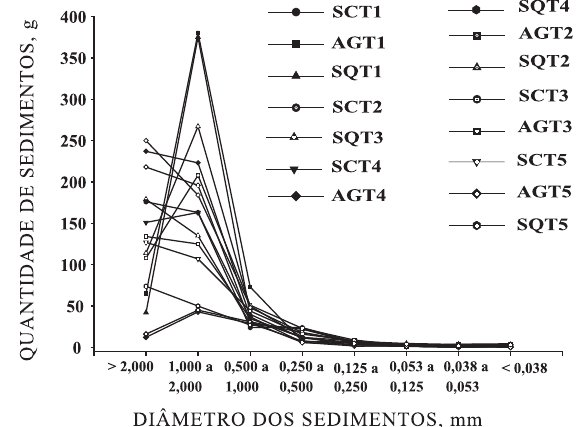
Figura 2. Distribuição dos sedimentos presentes na enxurrada, em função do diâmetro das partículas e do tratamento, durante o ciclo da soja nos testes 1 (T1), 2 (T2), 3 (T3), 4 (T4) e